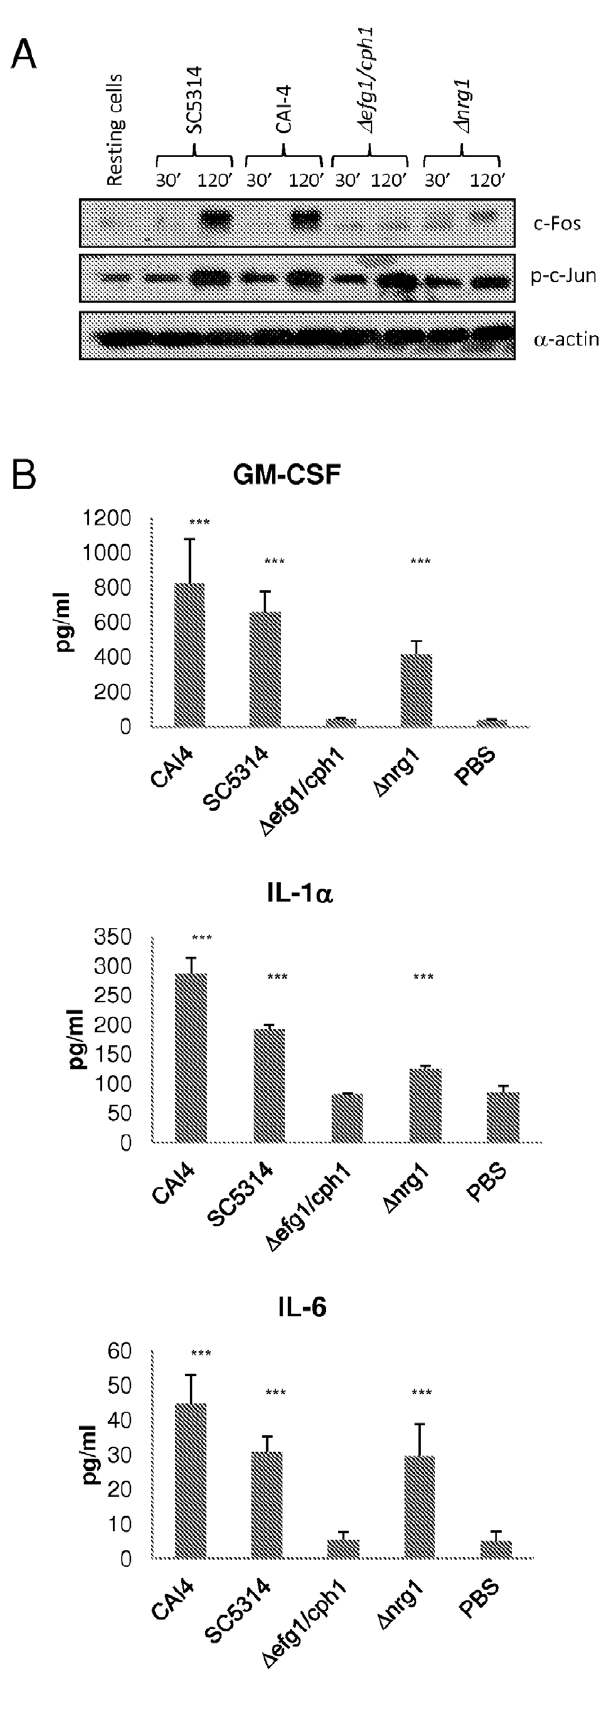
Figure 4. Induction of c-Jun phosphorylation, c-Fos and cytokine production in A431 vaginal epithelial cells is depen- dent on C.albicans hypha formation. (A) C. albicans SC5314 (wild type), CAI4 (parent control), D efg1/cph1 (non-filamentous) and D nrg1 (hyperfilamentous) were added to A431 vaginal ECs under standard culture conditions for 30 min and 2 h. Total protein was isolated and induction of c-Jun phosphorylation and c-Fos assessed by Western blotting. Bands are shown alongside an a -actin loading control. (B) Cytokine protein production by A431 ECs 24 h post-infection with all four strains as measured by multiplex microbead assay (luminex). A C. albicans :EC MOI of 10:1 (A) and 0.01 (B) was used. Data are representative (A) or mean 6 SEM (B) of three independent experiments. Statistical analysis (B) of SC5314, CAI-4, D efg1/cph1 and D nrg1 infected versus PBS-treated controls was performed using the ANOVA test with Bonferroni post-hoc analysis. ***=p ,